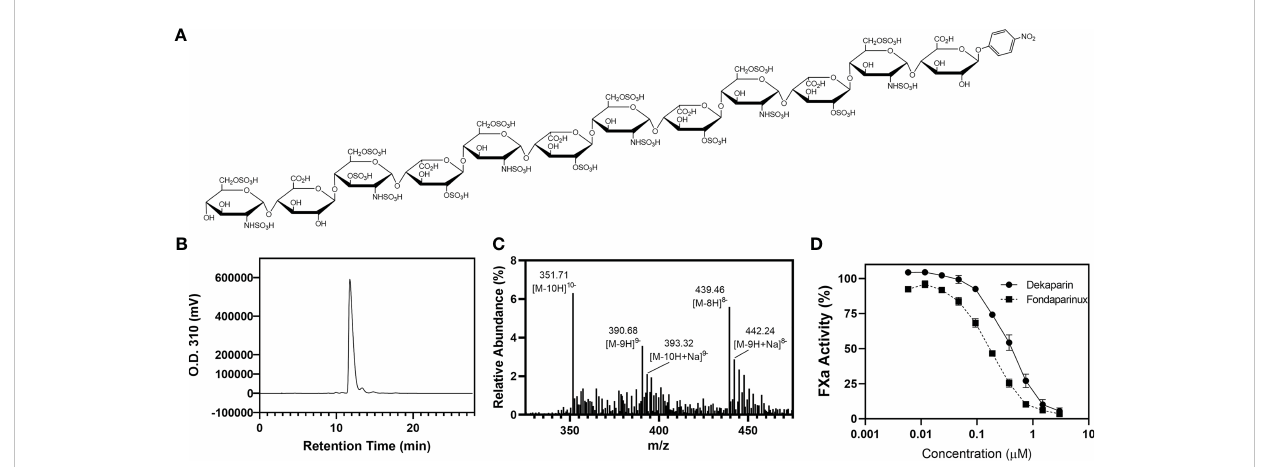
FIGURE 1 Dekaparin chemical structure, purity, and anti-FXa activity. (A) Dekaparin chemical structure prepared by chemoenzymatic synthesis. (B) HPLC chromatogram of dekaparin. (C) Electrospray ionization mass spectrometry (ESI-MS) spectrum collected in negative mode. Molecular weight (MW) determined from ESI-MS analysis is 3525.35 +/- 1.6 Da, which is close to the calculated MW of 3523.76 Da. (D) Anti-FXa activity illustrates dekaparin ’ s anticoagulant activity. Fondaparinux is included as a control. HPLC, high performance liquid chromatography; FXa, factor